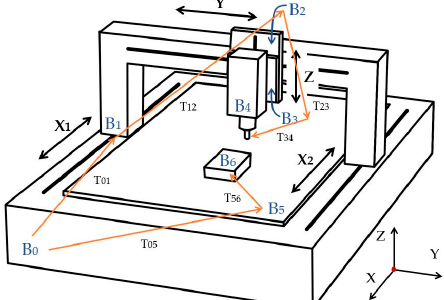
Figure 1. Structure of the gantry-moving engraving and milling machine. B 0 -bed, B 1 -moveable gantry, B 2 -Y direction slide, B 3 -Z direction slide, B 4 -spindle with the tool, B 5 -workbench, B 6 -workpiece. T 01 –T 56 represent the coordinate transformation between the components.